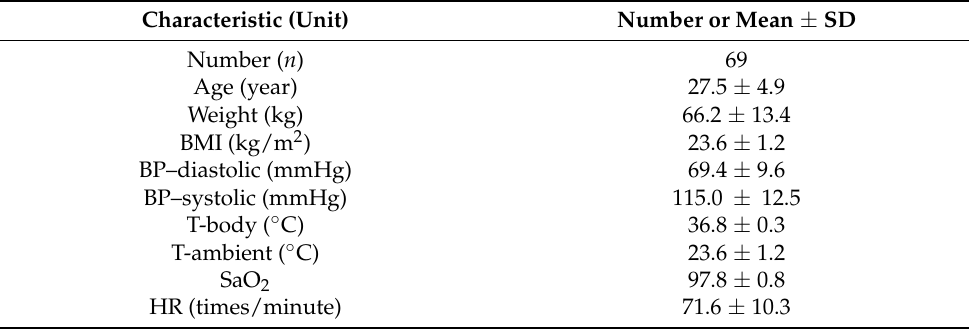
Table 4. Table of basic physiological parameters for subjects. Characteristic